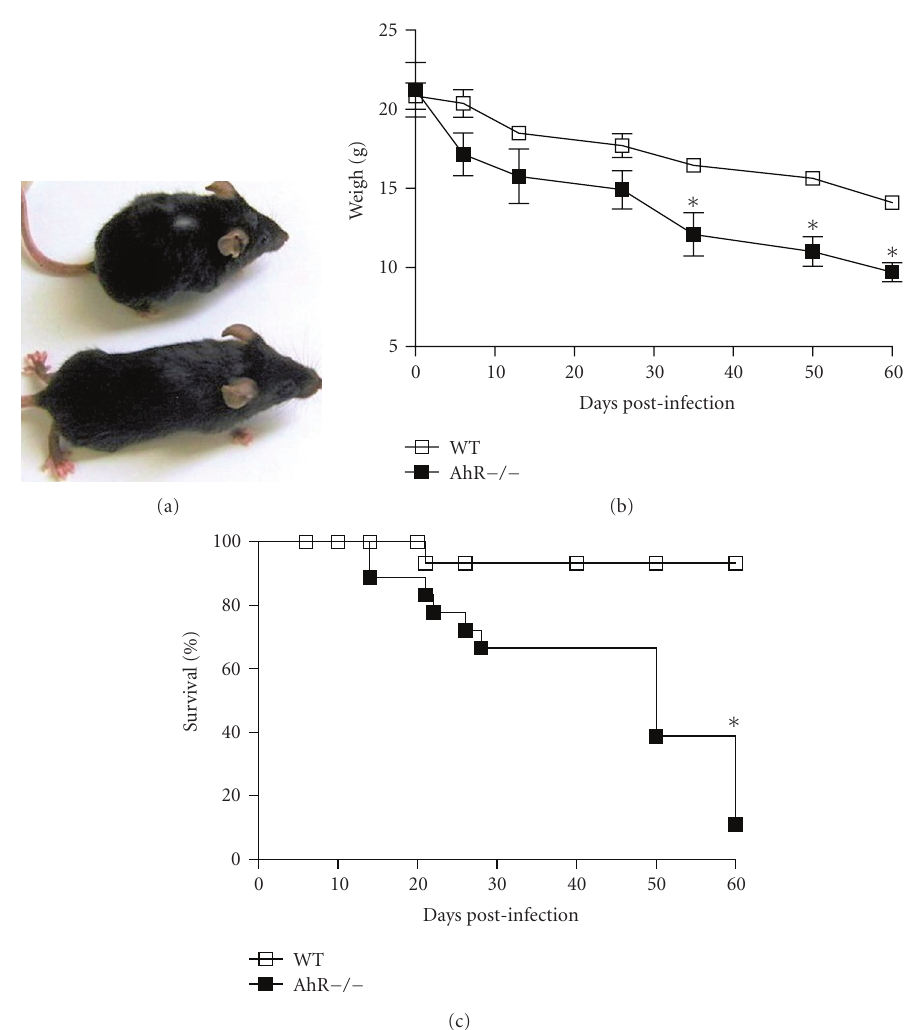
Figure 1: AhR-/- mice infected with T. gondii display profound weight loss and accelerated mortality compared to infected-wild type mice. Physical appearance (a), body weight (b), and survival rate (c) of AhR-/- and WT mice infected with 40 cysts of T. gondii were monitored during the times indicated. The values presented are the mean + SD of at least 6 animals per time point per group. The experiment shown is representative of at least four performed that gave similar results. ∗ P < . 05 for body weight by student’s t -test; ∗ P < . 0001 for survival rate by log-rank test between the means of the values obtained with AhR-/- versus wild-type control